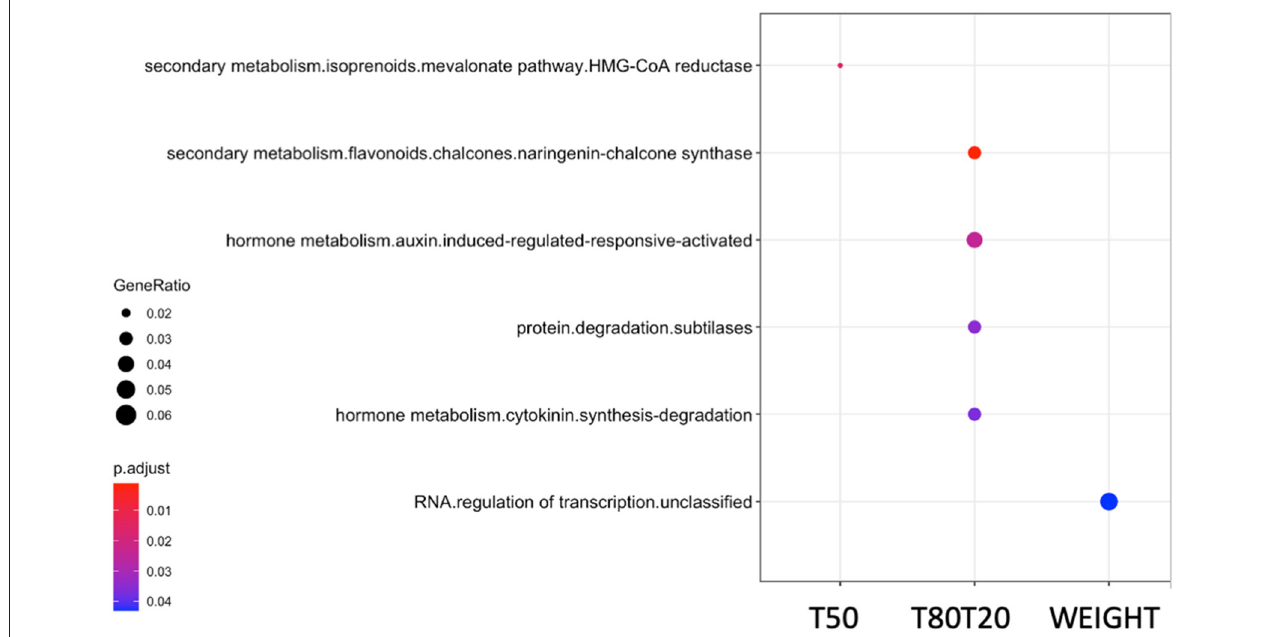
FIGURE 3 | GSEA analysis of candidate gene lists obtained from GWAS with different seed traits: germination speed (T50), germination homogeneity (T80T20), and seed weight (WEIGHT). Clusterprofiler was used to perform a hypergeometric test using the Mapman functional terms. The p -values were converted to FDR p .adjust-values as shown in colors, the red color being more significant than the blue color. The dot size represents the gene ratio between the total gene number annotated in functional classes and the number of these genes present in your input list. GSEA, gene set enrichment analyses; GWAS, genome-wide association analyses; FDR, false discovery